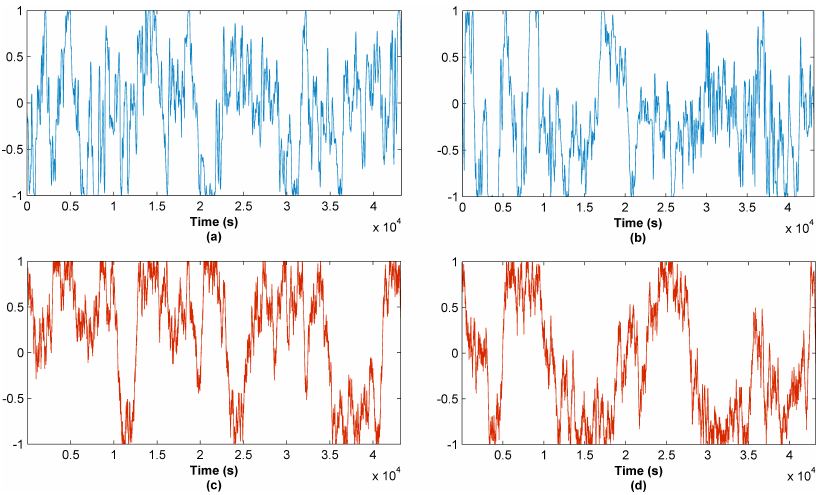
Figure 5. Illustration of real AGC signals curve ( a , b ), and sampled AGC signals curve ( c , d